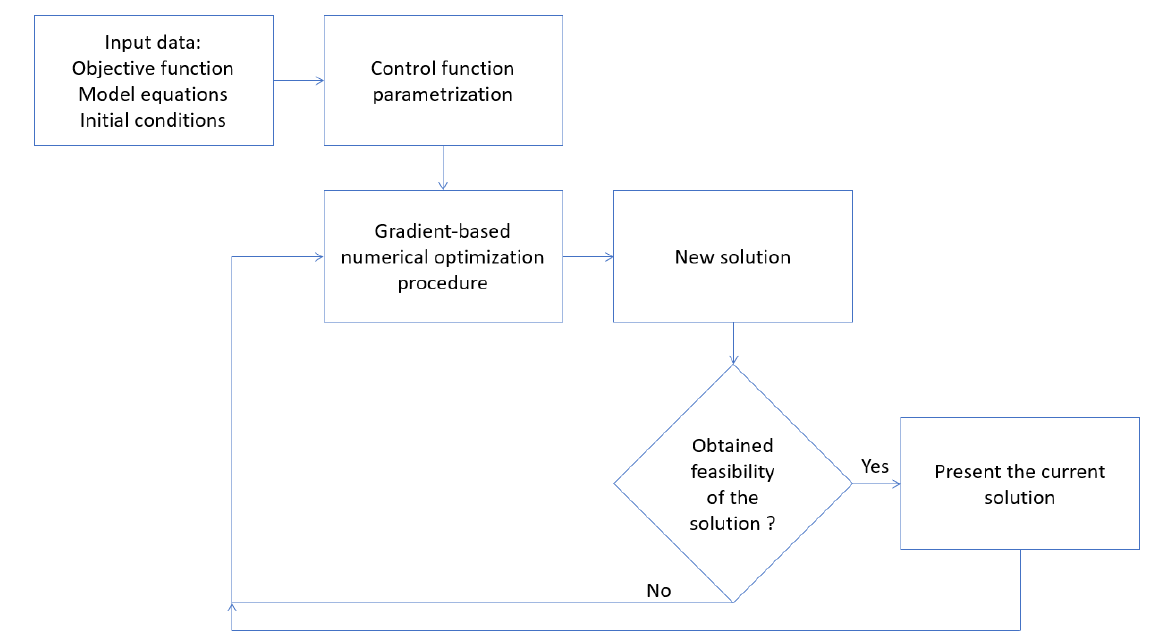
Figure 1. The scheme of the general solution